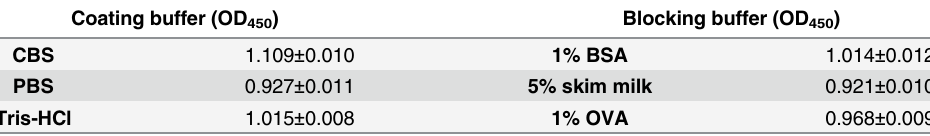
Table 2. Optimization of the coating buffer and blocking buffer.